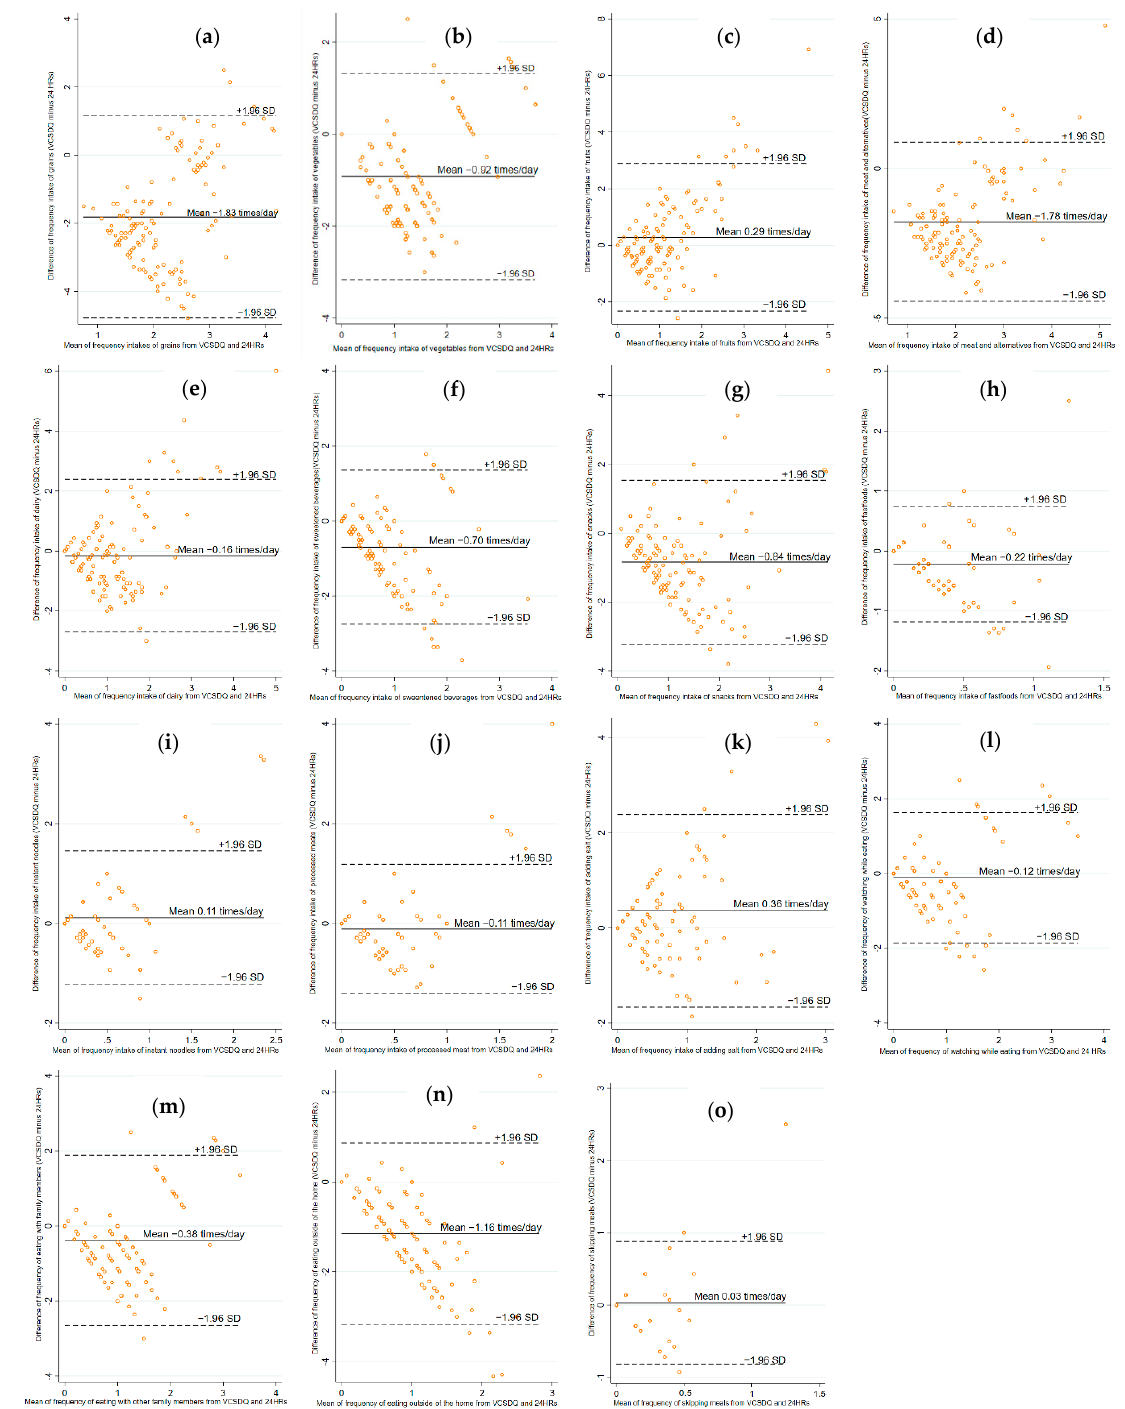
Figure 3. Bland–Altman plots describing the mean differences (VCSDQ minus 24 h recalls) for frequency intake of food groups and dietary practices in times per day: ( a ) grains; ( b ) vegetables; ( c ) fruits; ( d ) meat and alternatives; ( e ) dairy; ( f ) sweetened beverages; ( g ) snacks and discretionary foods; ( h ) fastfoods; ( i ) instant noodles; ( j ) processed meats; ( k ) adding salt; ( l ) watching screens while eating; ( m ) eating with family members; ( n ) eating outside of the home; ( o ) skipping meals. The solid line represents the mean, and the dashed lines represent the 95% limit of agreement (+1.96 SD and − 1.96 SD) of the observation. The y -axis shows the VCSDQ (test method) minus 24 h recalls (reference method) in times/day, the x -axis shows the mean between VCSDQ and 24 h recalls in times/day.